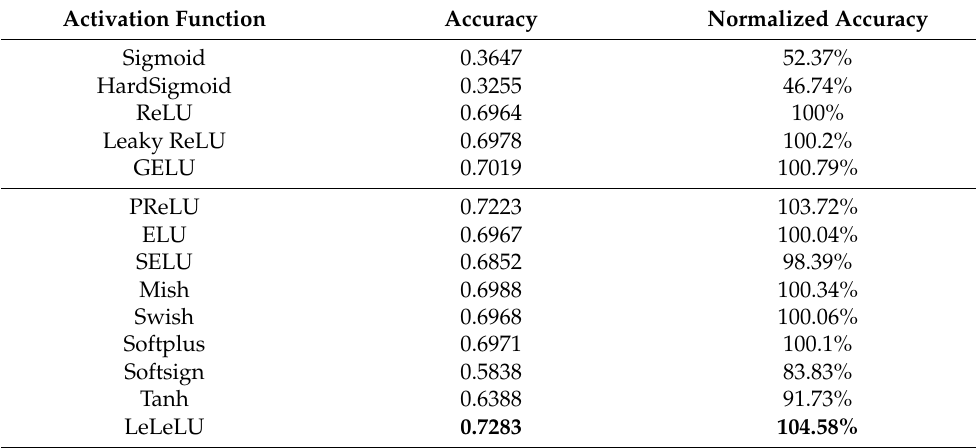
Table 7. Test accuracy in the CIFAR-100 dataset of the activation functions in question, using the ResNet-v1-56 neural network, and accuracy normalized to that attained by ReLU activation